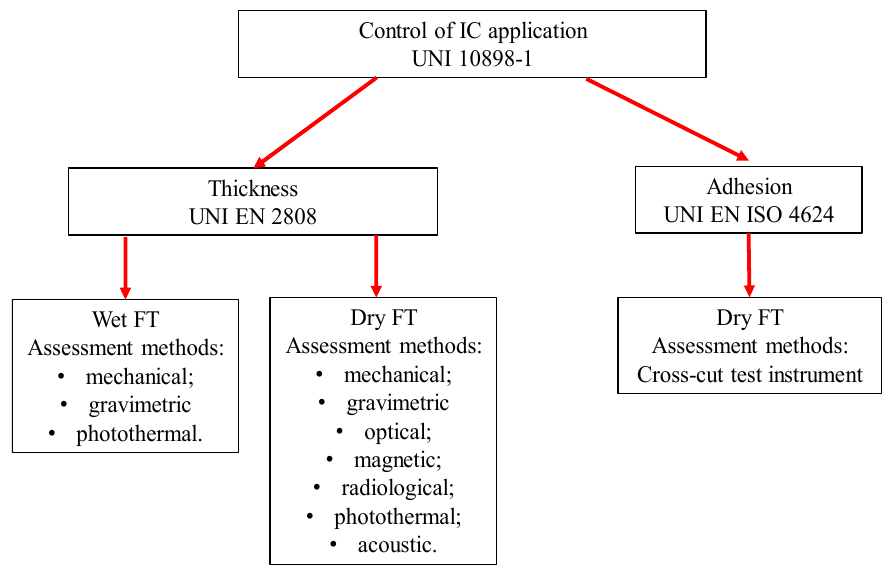
Figure 11. Methods for assessing the correct IC application.